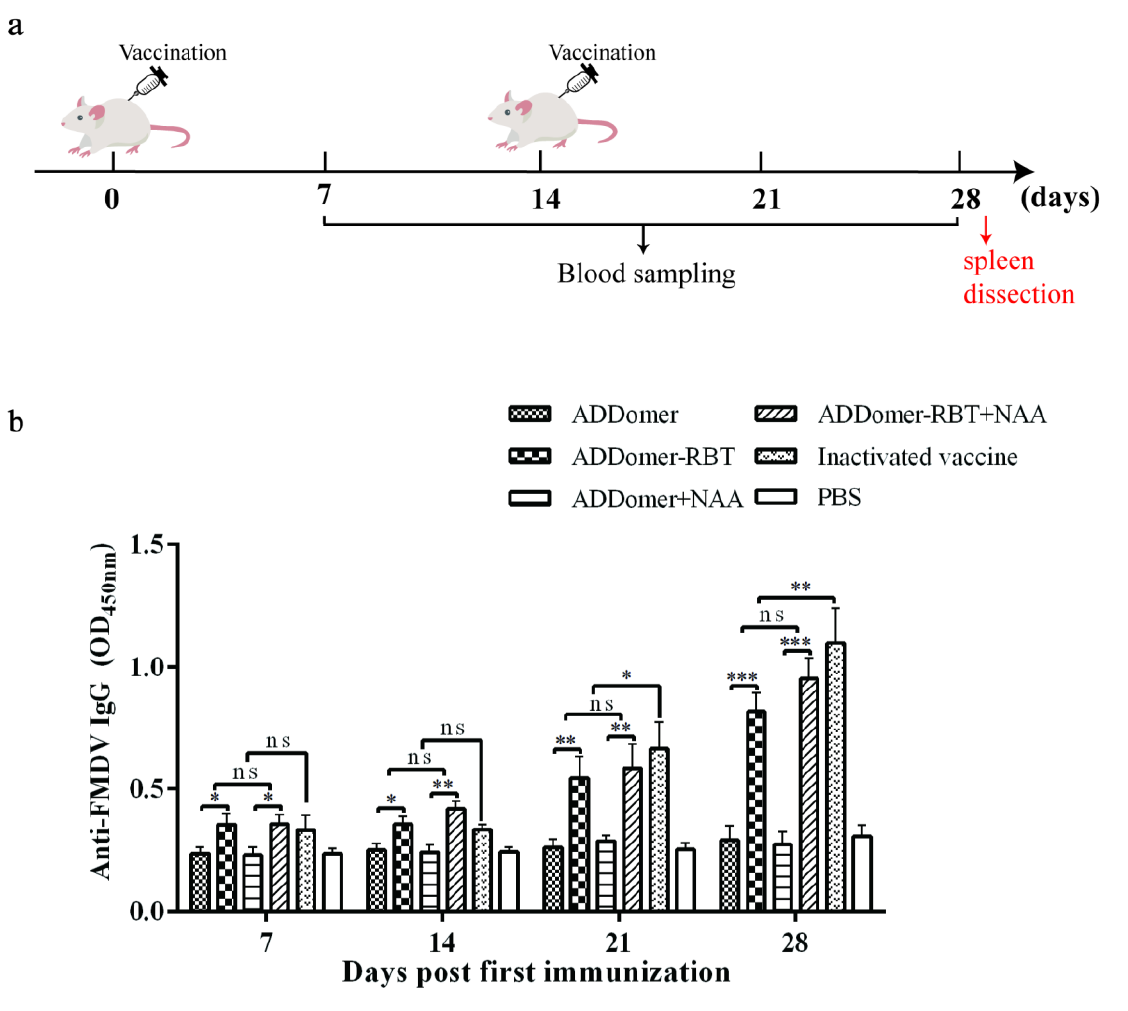
Figure 4. ADDomer-RBT VLPs induced antibody response in mice. ( a ) Immunization procedure of mice. ( b ) Detection of type O FMDV-specific IgG in mice sera (1:1000 dilution) by indirect ELISA using inactivated type O FMDV as coating antigens. Data represent the mean ± SEM. * represents a significant difference between the experimental groups ( p < 0.05), where * represents p < 0.05; ** represents p < 0.01; *** represents p < 0.001; ns represents no significant difference between the ex- perimental groups ( p > 0.05).